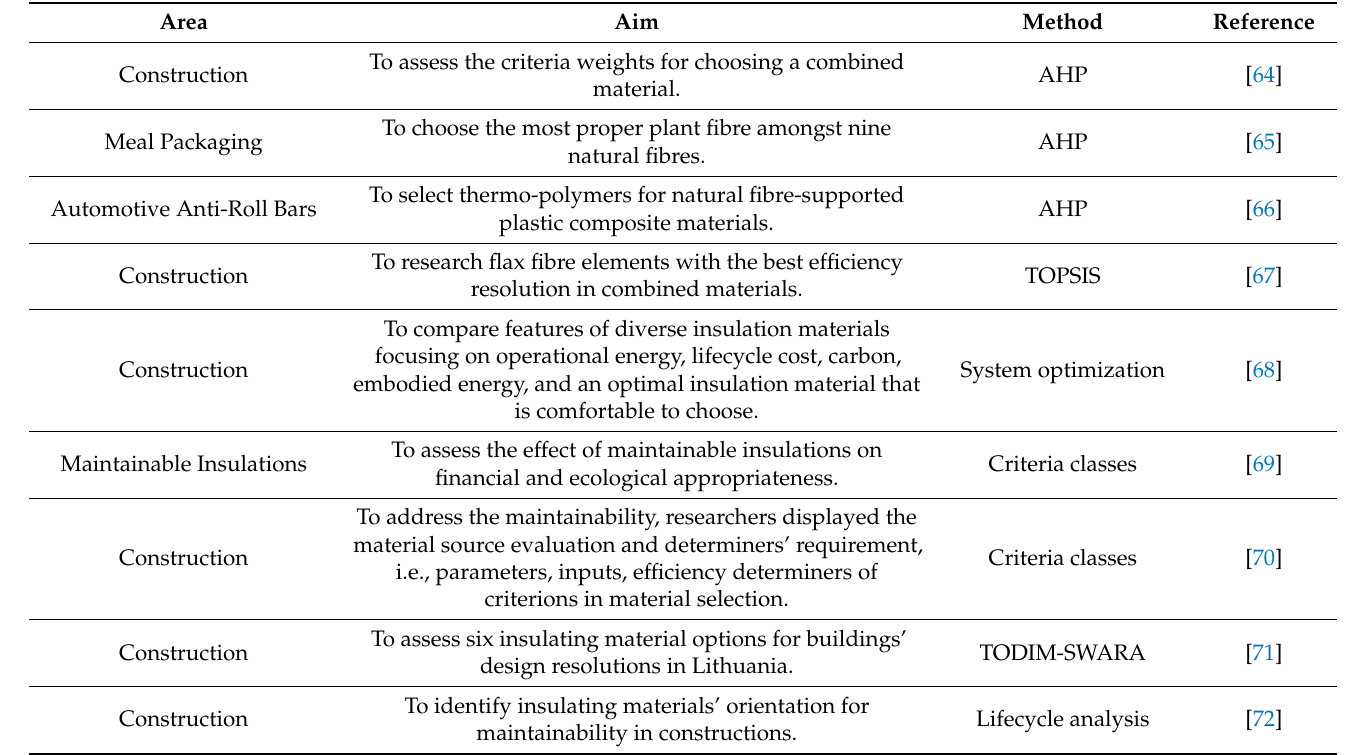
Table 2. Some MCDM research on material